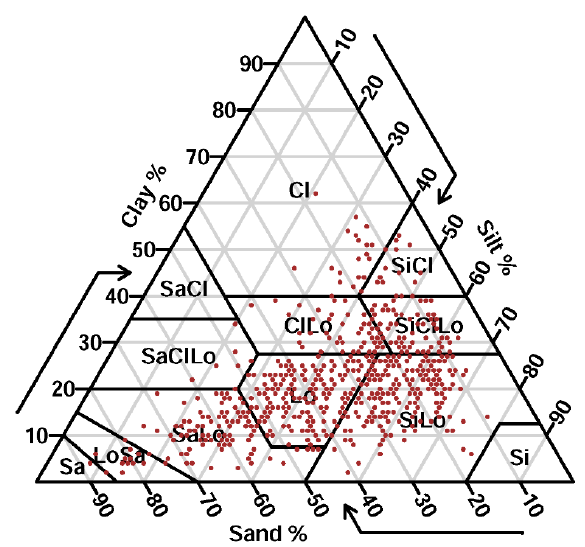
Figure 2. Soil texture diagram (USDA classification) of the topsoil in the study region ( n = 688). Data are based on the digital soil map of Austria (eBod, [38]).